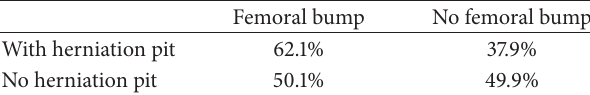
Table 2: Relationship between femoral bump and herniation